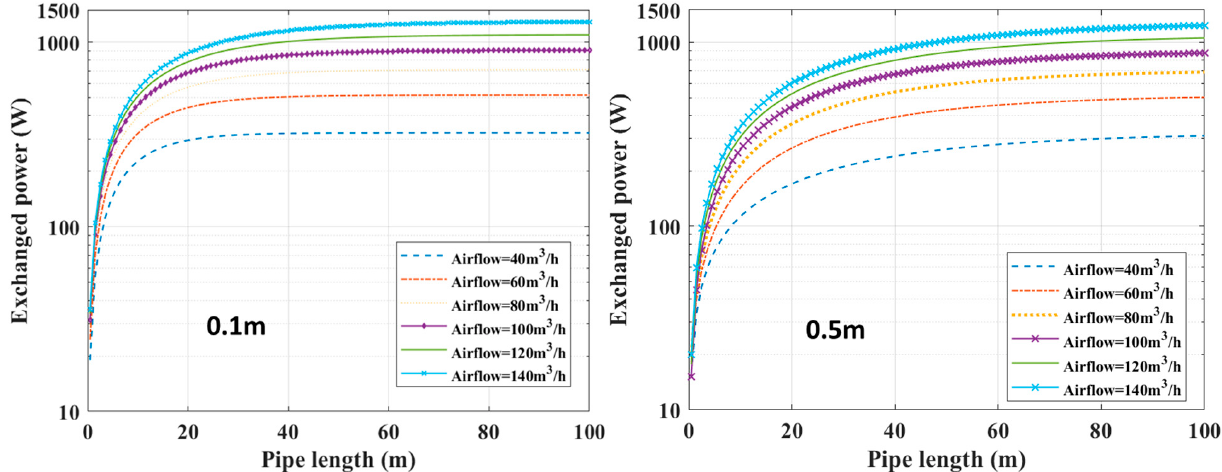
Figure 9. Exchanged heat power of the EAHE system as a function of pipes length and airflow for 0.1 and 0.5 m pipe diameters.